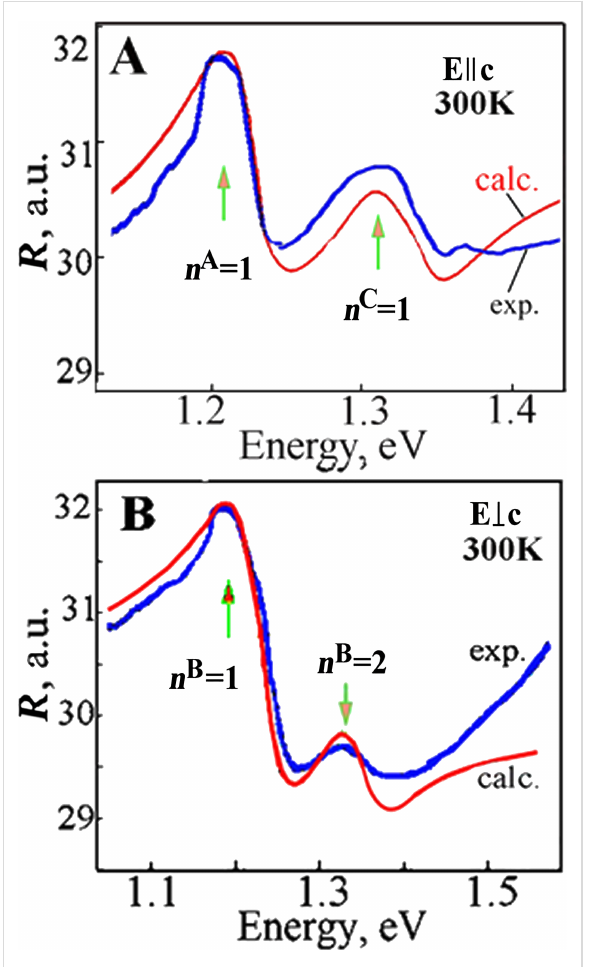
Figure 6: The experimentally measured (exp.) and calculated (calc.) profiles of the reflection spectra for the Е || с (A) and Е ⟂с (B) polariza- tion cases at 300 K.